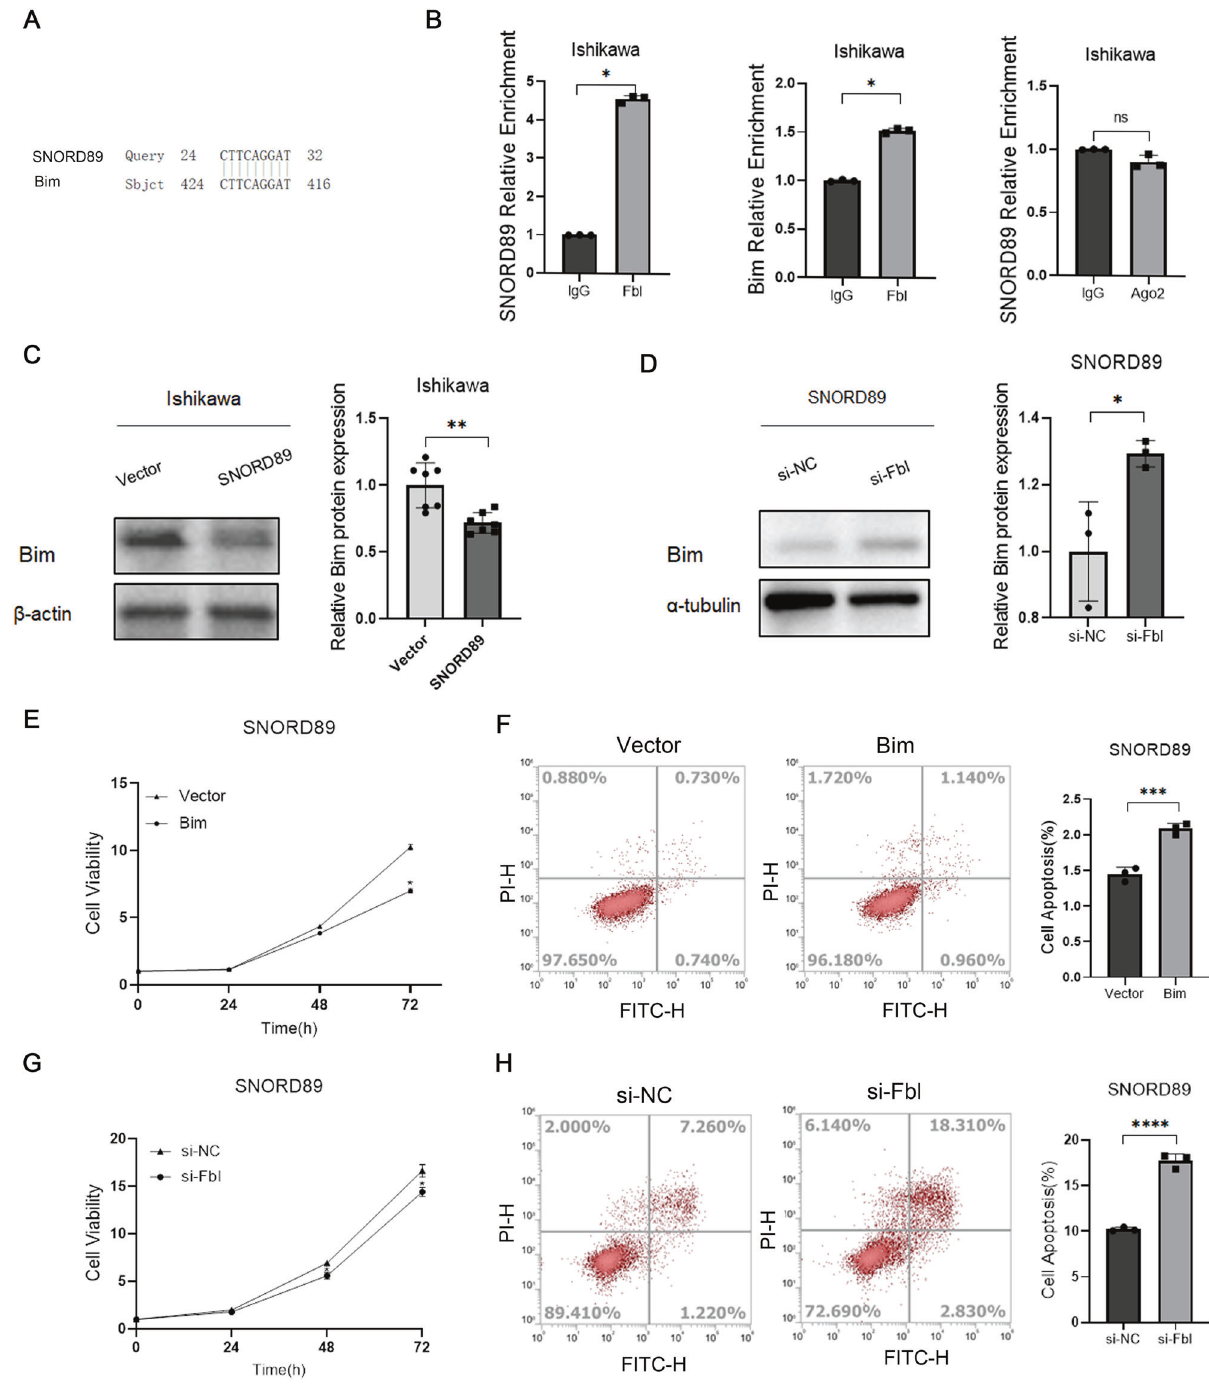
Fig. 4 The relationship between SNORD89 , Bim , and Fbl . A There are pairing points between SNORD89 and Bim ; B Fbl can bind Bim mRNA and SNORD89 , but SNORD89 cannot bind Ago2 ( n = 3). C Overexpression of SNORD89 in Ishikawa cells can reduce the protein level of Bim ( n = 6); D Downregulation of Fbl can increase the overexpression of Bim protein in Ishikawa cells ( n = 3); E – H downregulation of Fbl or overexpression of Bim can reverse the oncogenic effect of SNORD89 ( n = 3); Values are presented as the mean ± SD. * p ≤ 0.05; ** p ≤ 0.01; *** p ≤